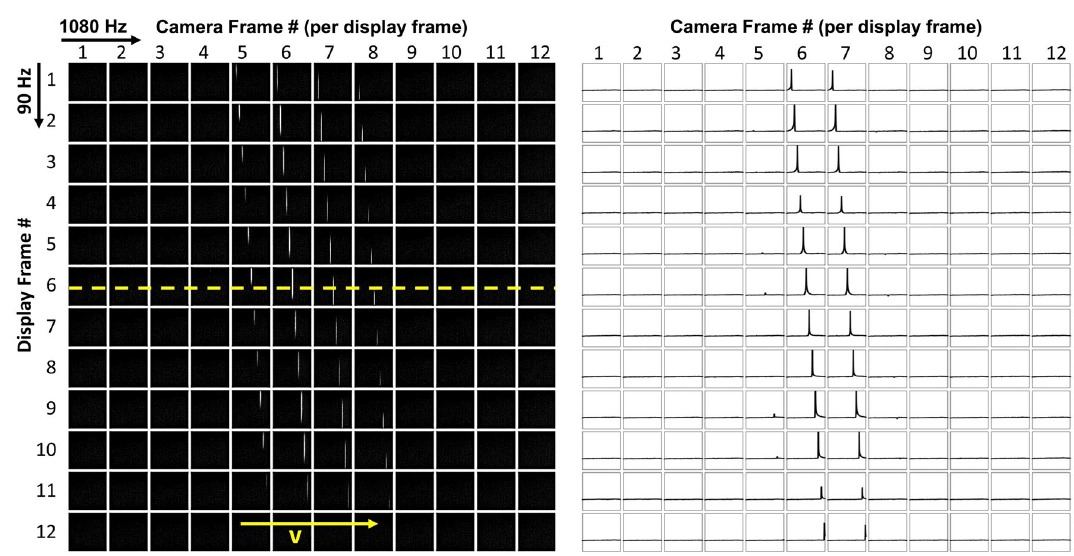
Figure 3. Illustration of the spatiotemporal measurements and the LSFs of a moving line shown on the 90 Hz VIVE Pro using the high-speed camera at 1080